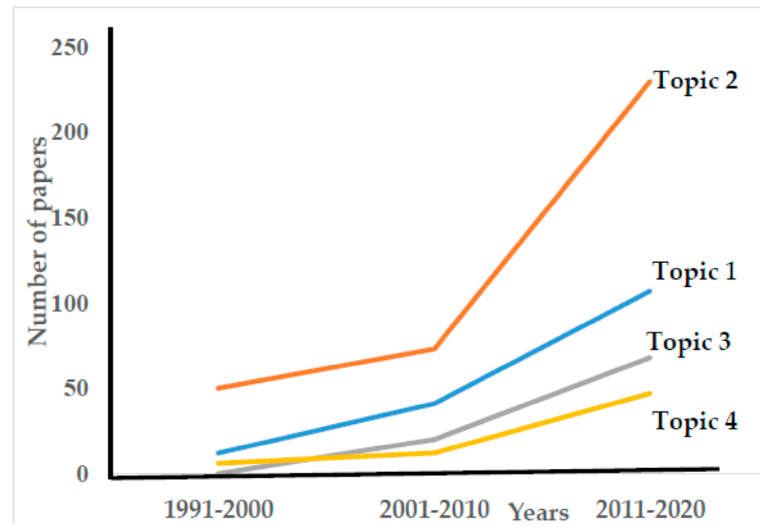
Figure 1. Evolution of the number of papers about mycorrhizal and endophytic fungi published, in the last three decades.